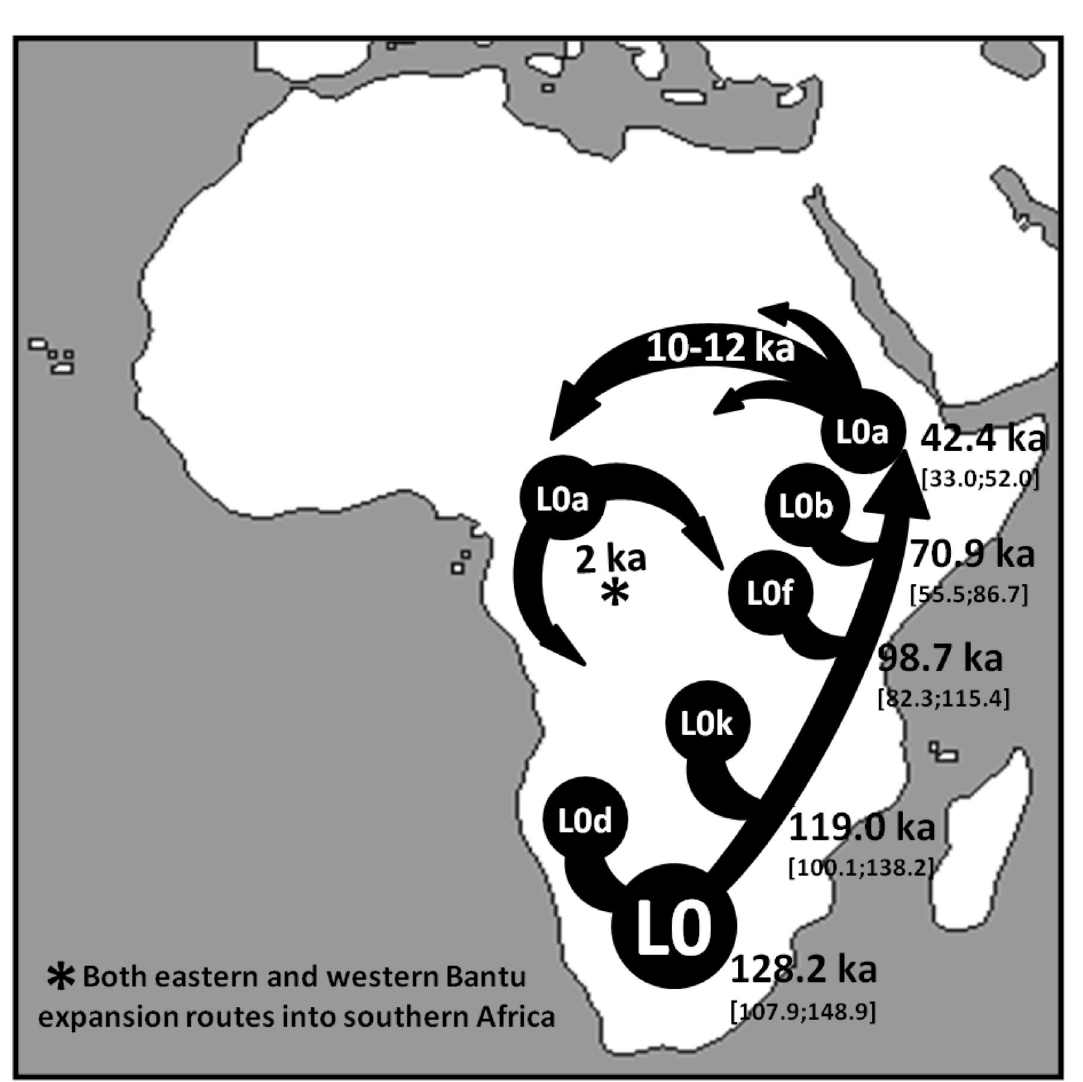
Figure 5. Schematic representation of the major inferred migrations involving mtDNA haplogroup L0.